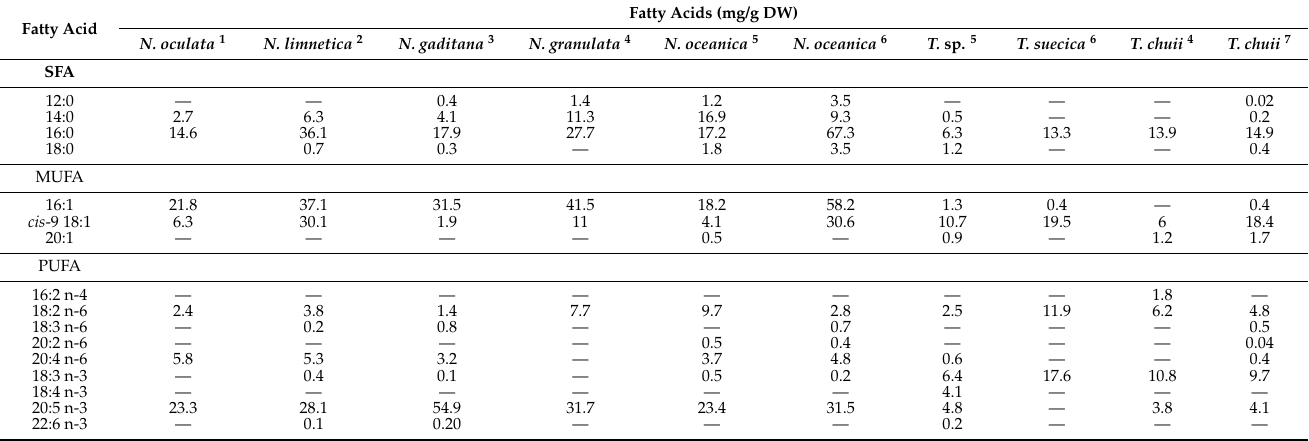
Table 2. Composition of fatty acids (expressed as mg/g of dry weight, DW) of Nannochloropis sp. and Tetraselmis sp. microalgae biomass. Fatty Acids (mg/g